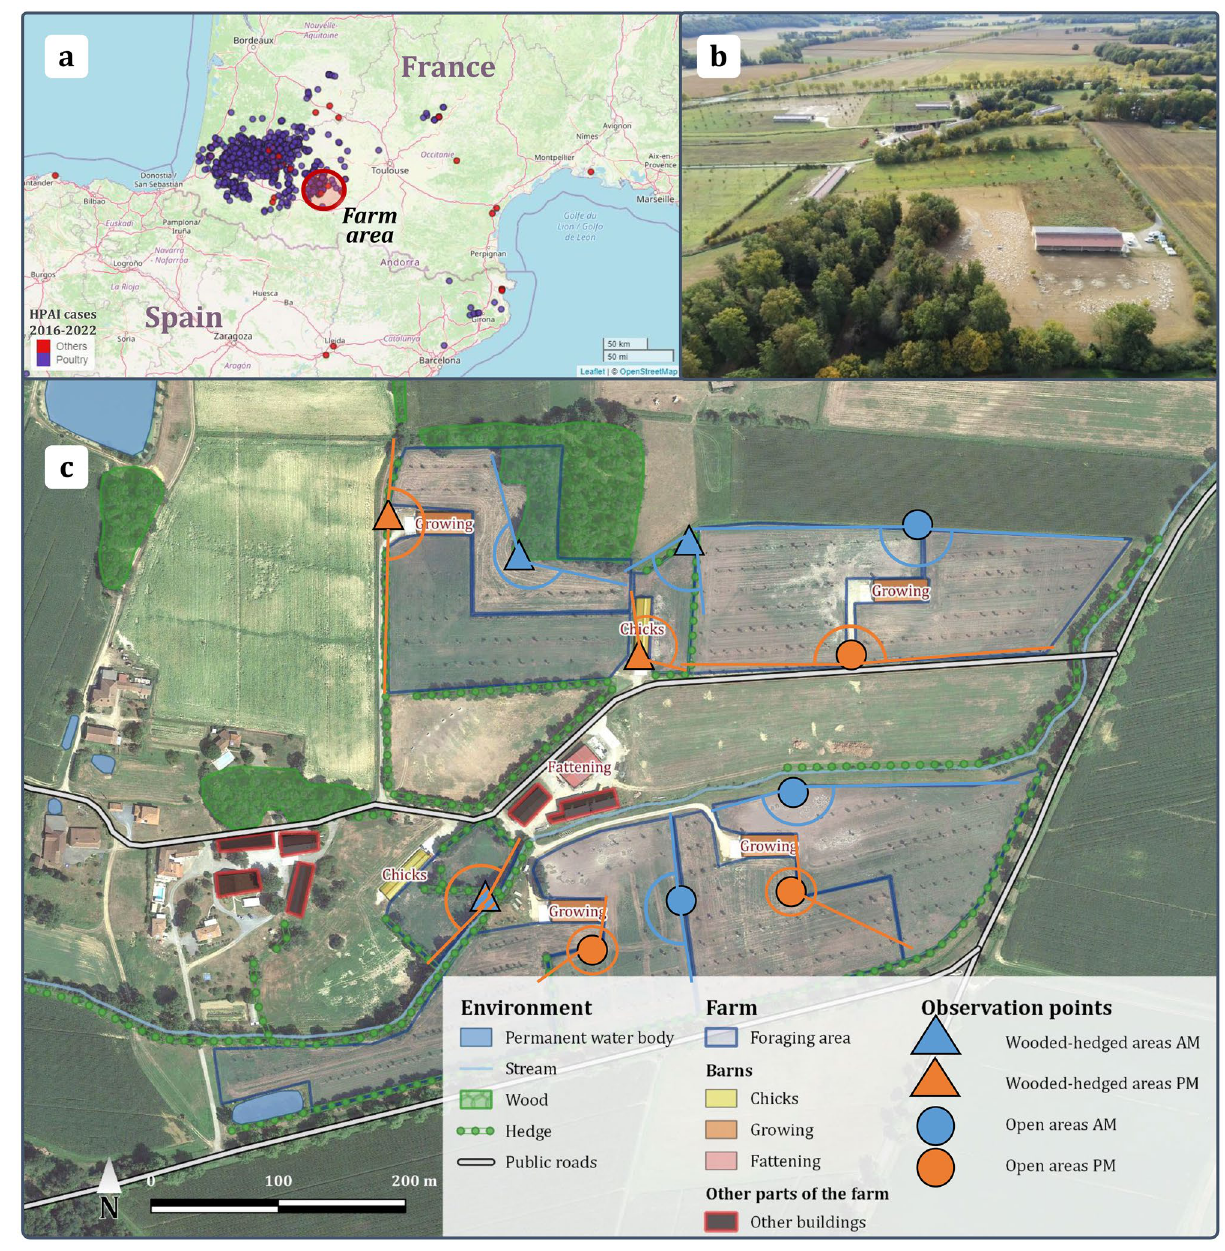
Figure 1. Environment of the study farm. ( a ) Geographic location of the farm (red circle) compared to locations of outbreaks and cases in poultry (purple) and wild birds (red) of highly pathogenic avian influenza (HPAI) from October 2016 to February 2022. Base map is the interactive HPAI map from Plateforme ESA accessible on https:// shiny- public. anses. fr/ shiny- vsi/ (April 2022). ( b ) North aerial view of the farm (drone photography taken by the authors). ( c ) Map of the farm showing the natural environment surrounding duck foraging areas. Unlabelled buildings are private houses that are not part of the farm. Observation points are marked on each studied area by type of surrounding environment (shape) and time of day (colour), with their field of view indicated as lines delimitating the angle connected by curved line (circle when a point is used for two areas). The map is produced using QGIS 31 version 3.6.1-Noosa, with a base map from Google, Image © 2022 CNES/Airbus, Maxar function of the “vegan” package on R software version 4.0.5 34 . The three indices were defined by the following